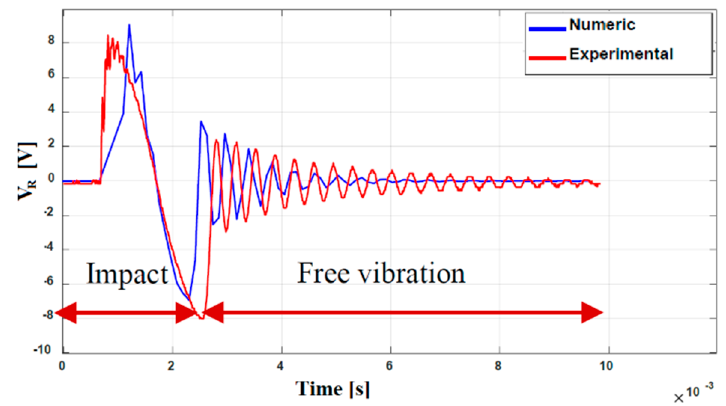
Figure 14. Experimental and numerical voltage vs. time plots.